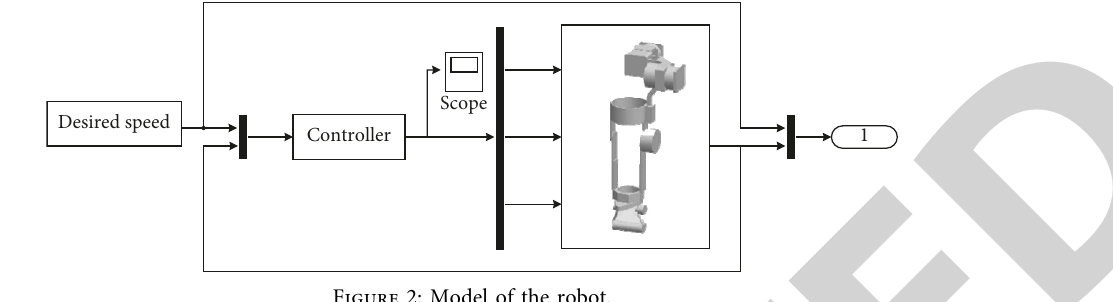
Figure 2: Model of the